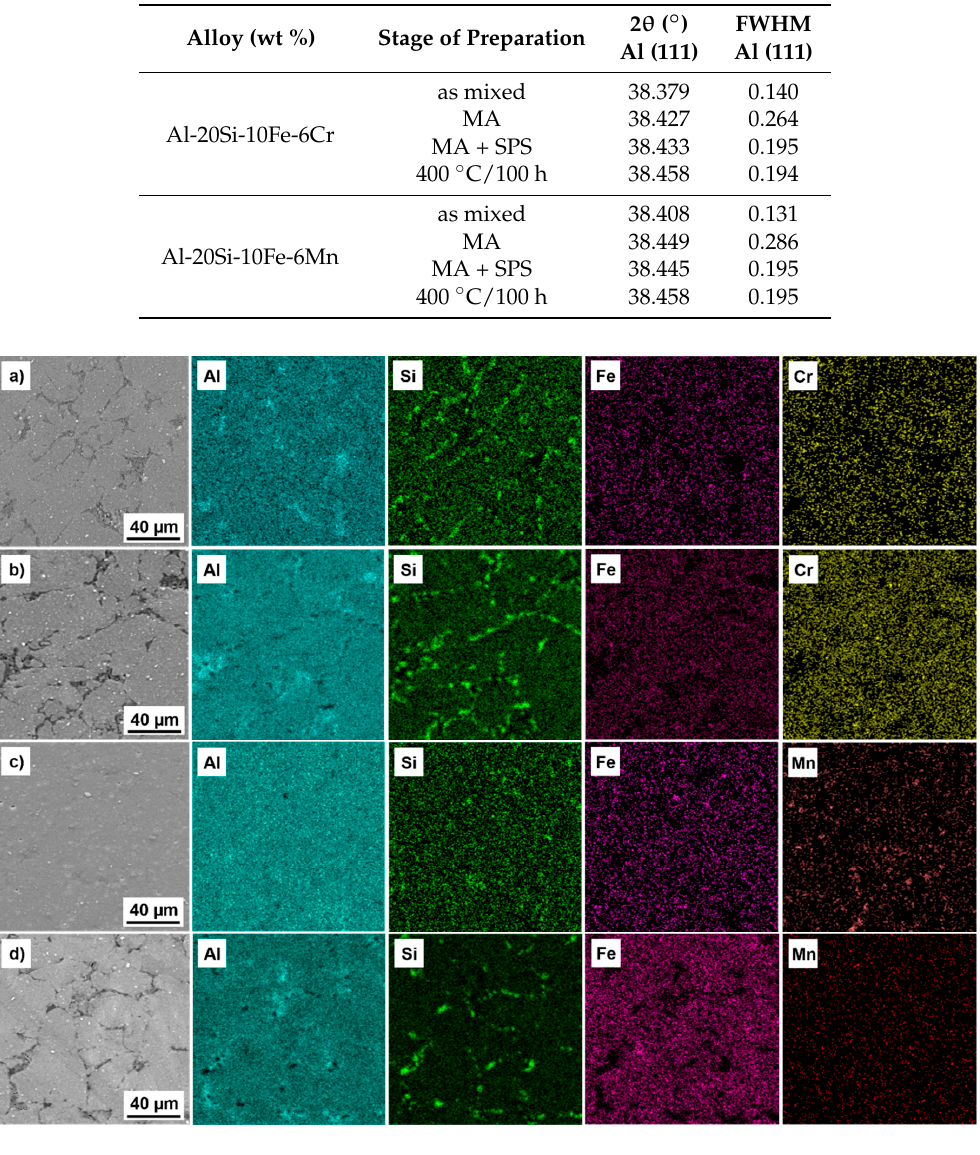
Table 1. Summary of the results of XRD analysis of the Al (111) peak in the investigated alloys at different stages of preparation (2 θ , diffraction angle; FWHM, Full Width at Half Maximum).